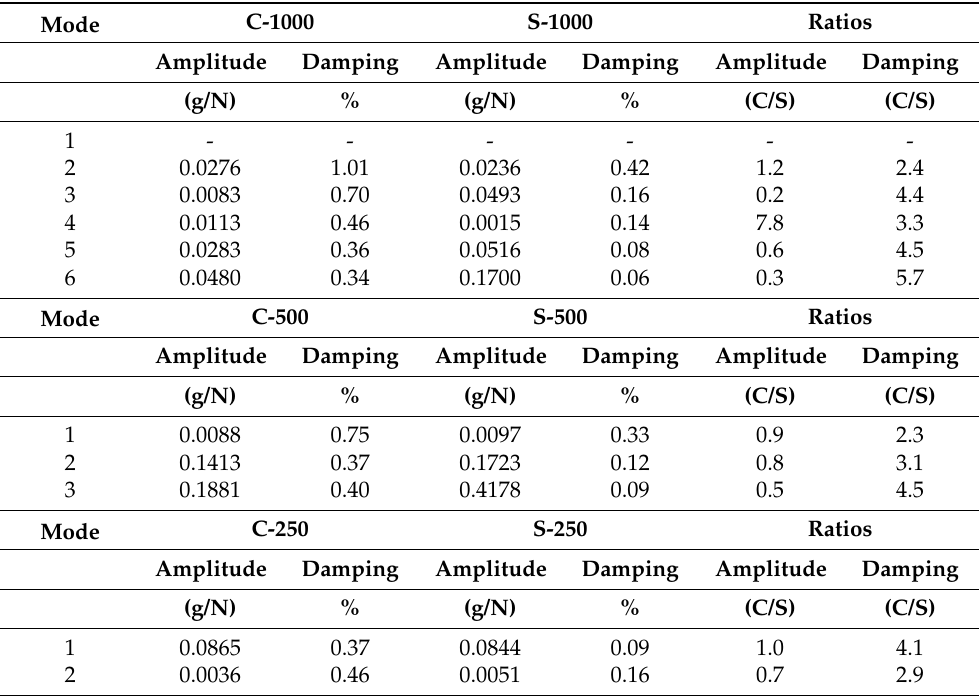
Table 17. Amplitudes of acceleration and the respective damping